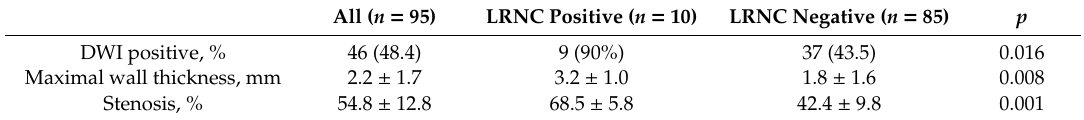
Table 2. Di ff usion weighted imaging findings and plaque burden of